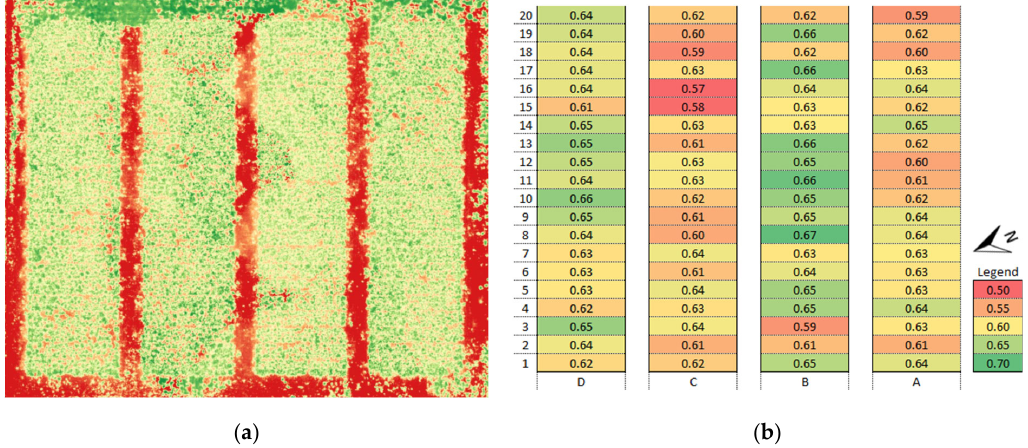
Figure 5. Orthomosaic of NDVI values from the multispectral UAV survey from 1 May 2020 ( a ) and average NDVI values calculated for individual plots of the field trial ( b ).